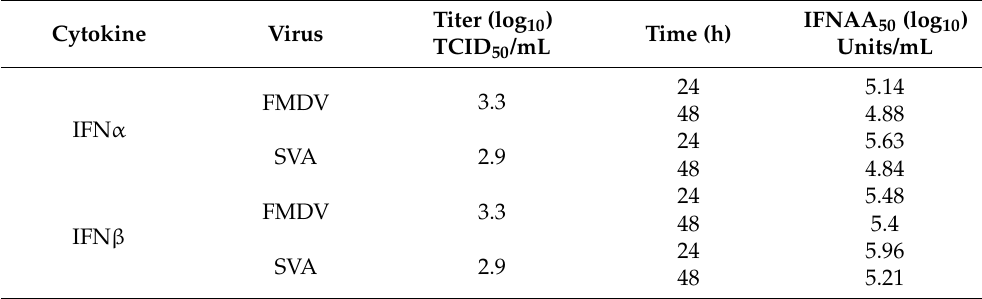
Table 2. Sensitivity of FMDV and SVA to type I interferons on LF-BK α V β 6 cells. Interferon activity is presented as units of Interferon Antiviral Activity capable of inhibit 50% of viral growth (IFNAA 50 ) per 1 mL after 24 and 48 h of incubation as calculated by the Spearman-Kärber Method.